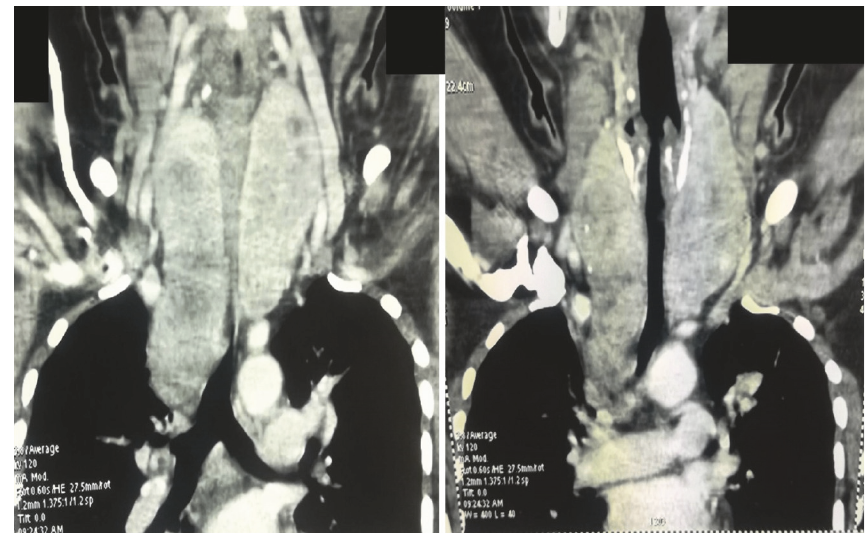
Figure 1: Cervical computed tomography scan revealed an enlarged plunging multinodular thyroid